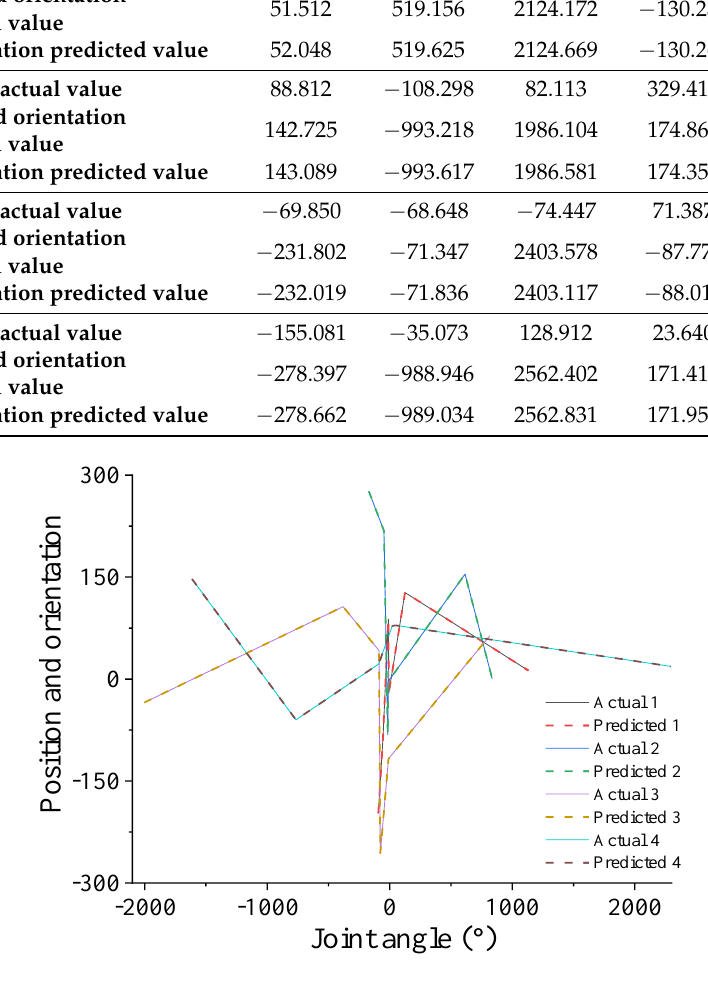
Figure 18. Comparison curves of analytic and predictive solutions of inverse kinematics. Table 9. Comparison of analytic and predictive solutions of inverse kinematics.